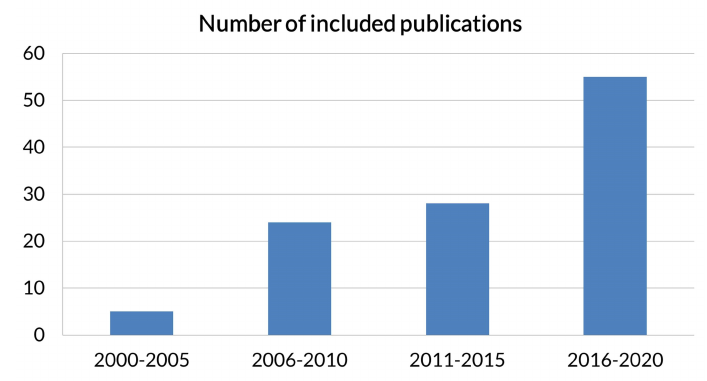
Figure 3. The number of publications per 5-year